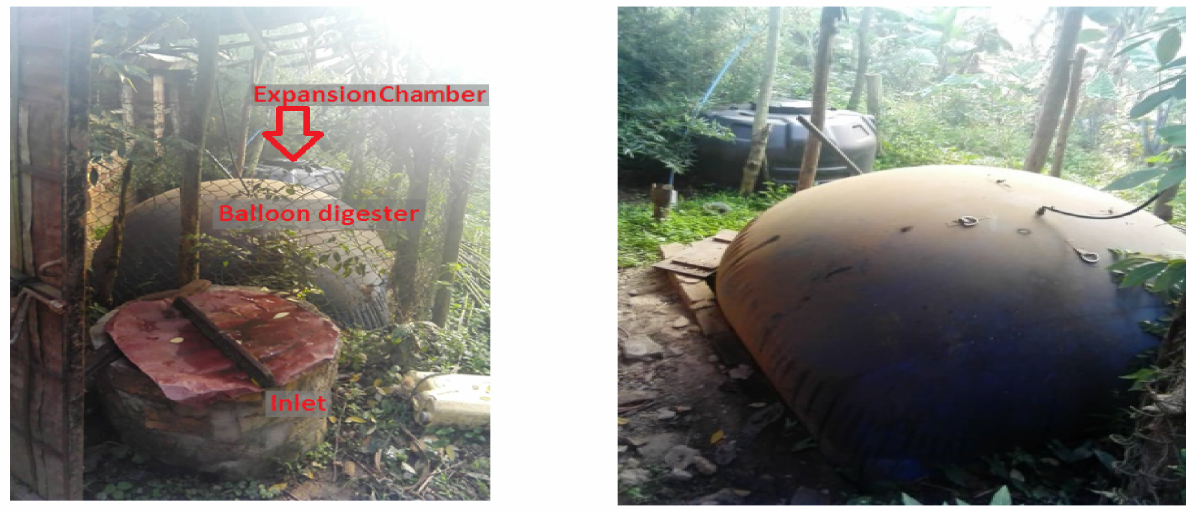
Figure 7. Balloon type